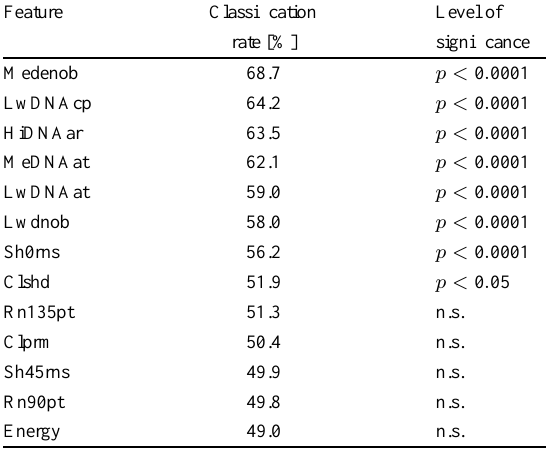
Classification rate of single features selected by classifier 1 or 2 for nuclei of NEte versus NCte